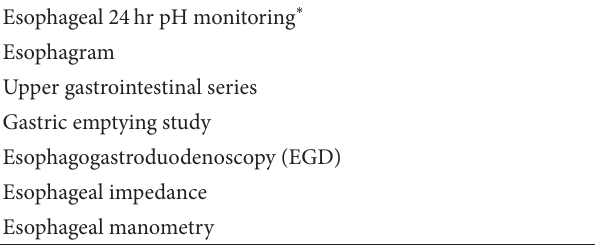
Table 2: Most commonly used diagnostic tests in the evaluation of GERD.